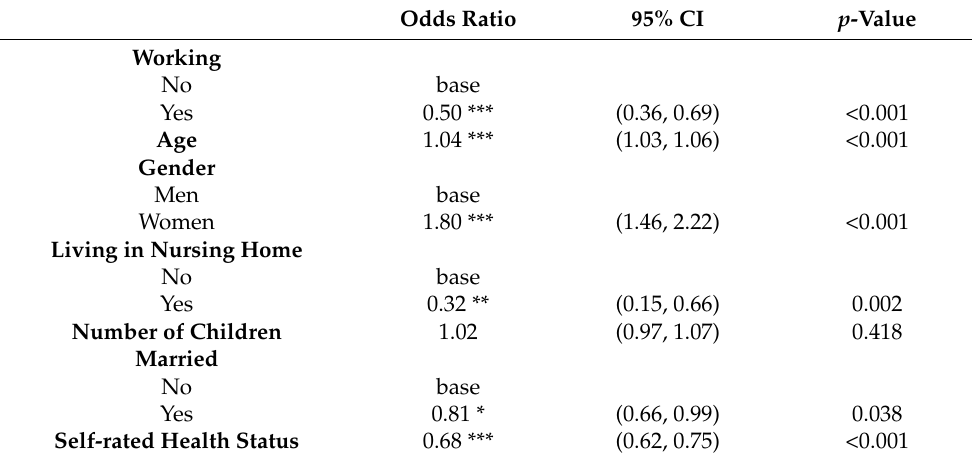
Table 4. Logistic Regression Predicting External Support Usage due to